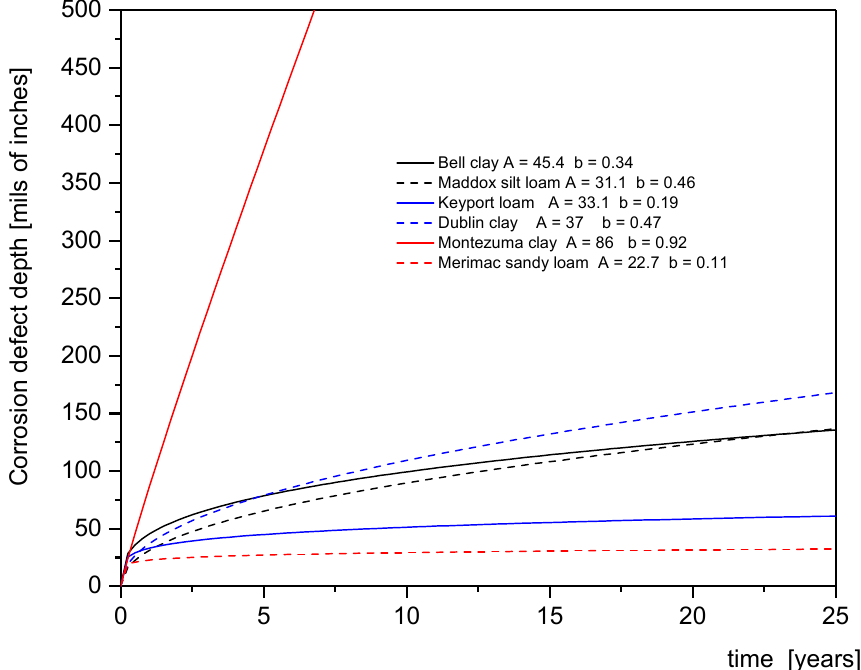
Figure 3. Evolution of the corrosion defect depth according to the information presented in Table 18 in the work titled Underground Corrosion by Romanoff adapted from [11].